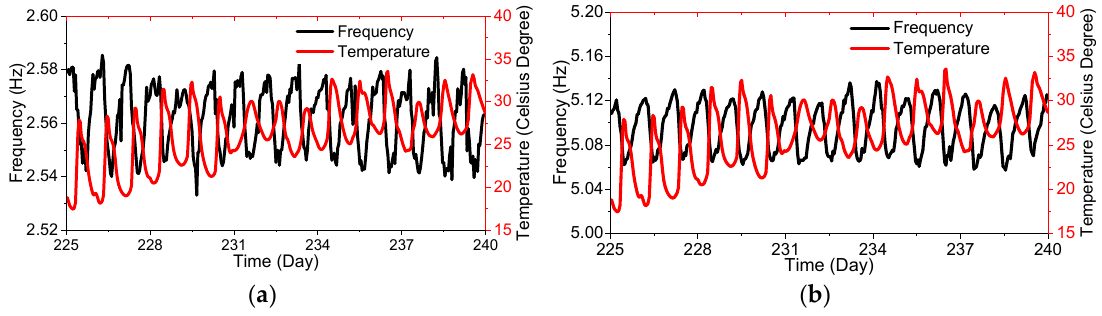
Figure 18. The relationship between the temperature and frequencies: ( a ) the 5th mode; ( b ) the 8th mode.